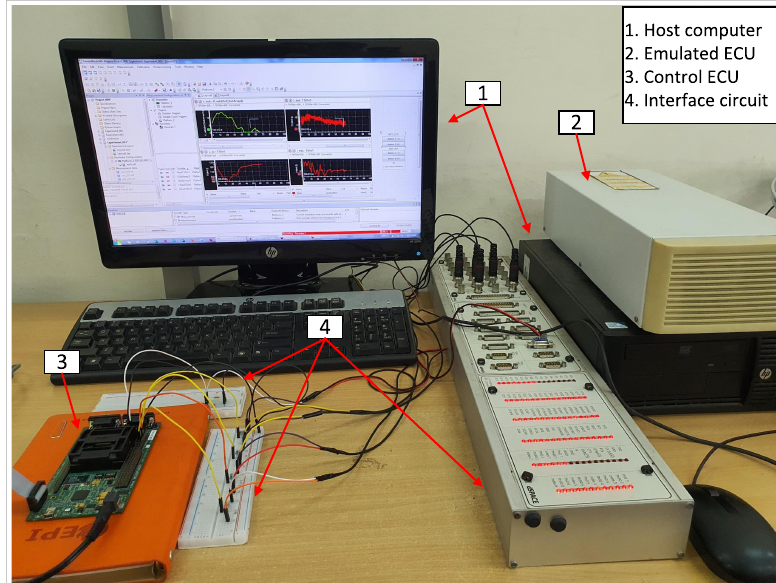
Figure 17. Experimental test